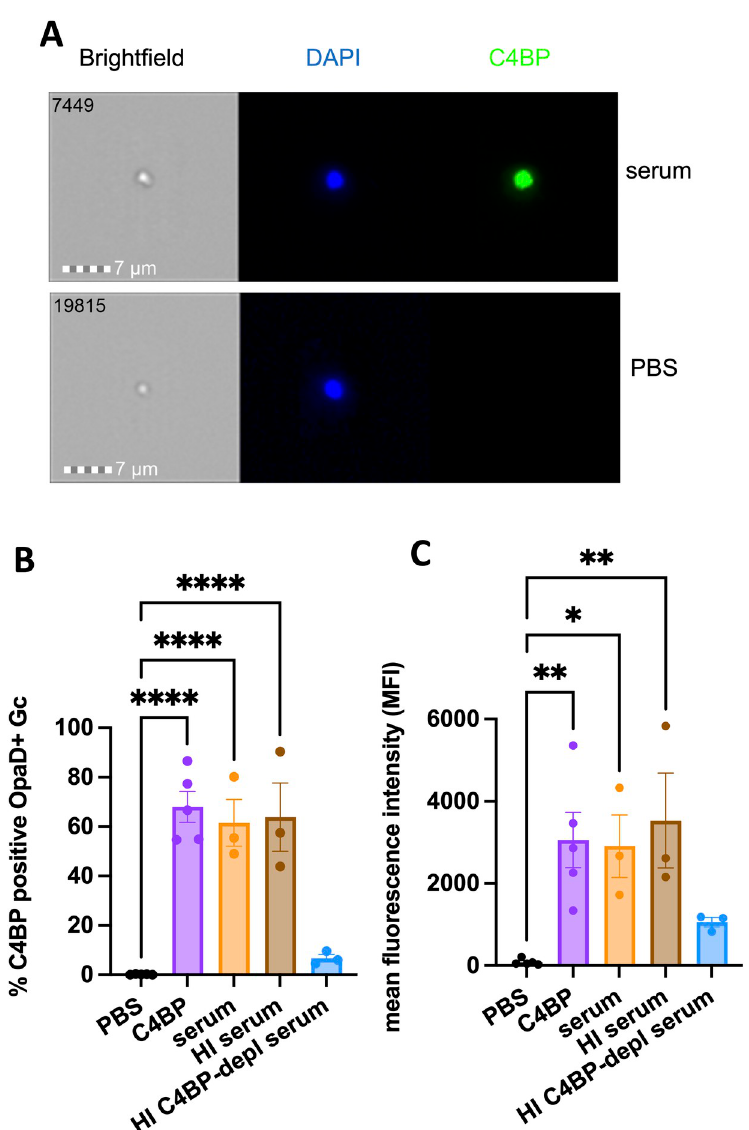
Fig 3. C4BP binds to OpaD+ Gc. OpaD+ Gc was incubated with 25% normal human serum (orange; UVA), heat- inactivated (HI) serum (brown), heat-inactivated C4BP-depleted (depl) serum (blue), or purified C4BP (50 μ g/ml; purple) for 20 minutes at 37˚C. Gc was fixed and stained with DAPI for intact bacteria (blue) and for C4BP using anti- C4BP antibody followed by Alexa Fluor 488-coupled goat anti-rabbit IgG (green), and analyzed by imaging flow cytometry. (A) Representative images (image numbers 7449 and 19815) of a single serum-incubated (top) and PBS- incubated (bottom) bacterium. (B) is the percent C4BP-positive bacteria and (C) is the mean intensity of AF488 fluorescence of the total bacterial population. In B-C, results are the mean ± SEM of 3 independent experiments. Statistical analyses were performed using one-way ANOVA with Tukey’s post-hoc comparisons to PBS. � p < 0.05, �� p < 0.01, ���� p <